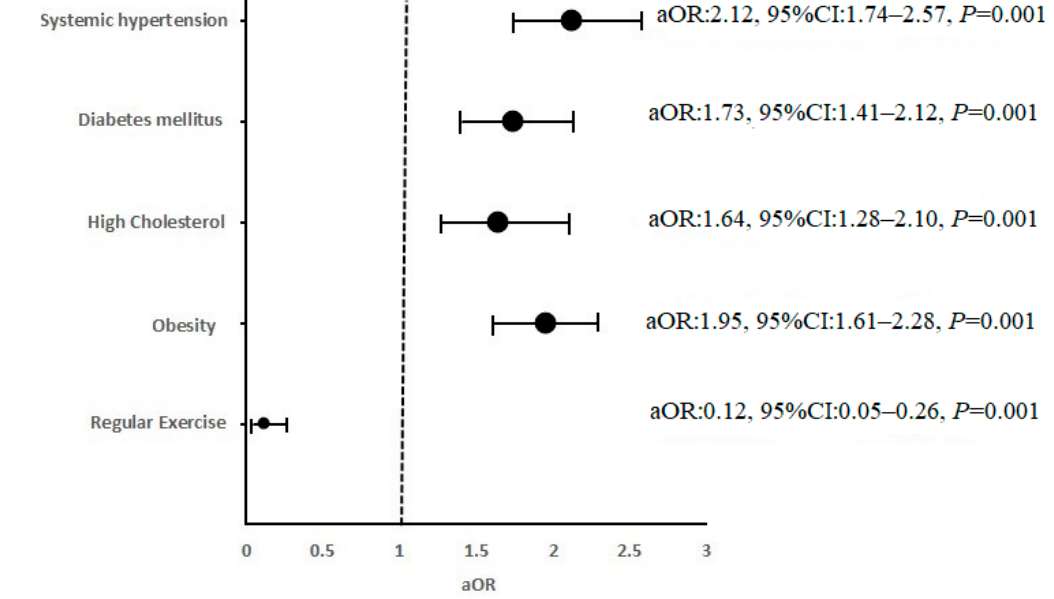
Figure 1. Forest plot showing the independent predictors for first-time stroke in the Aseer